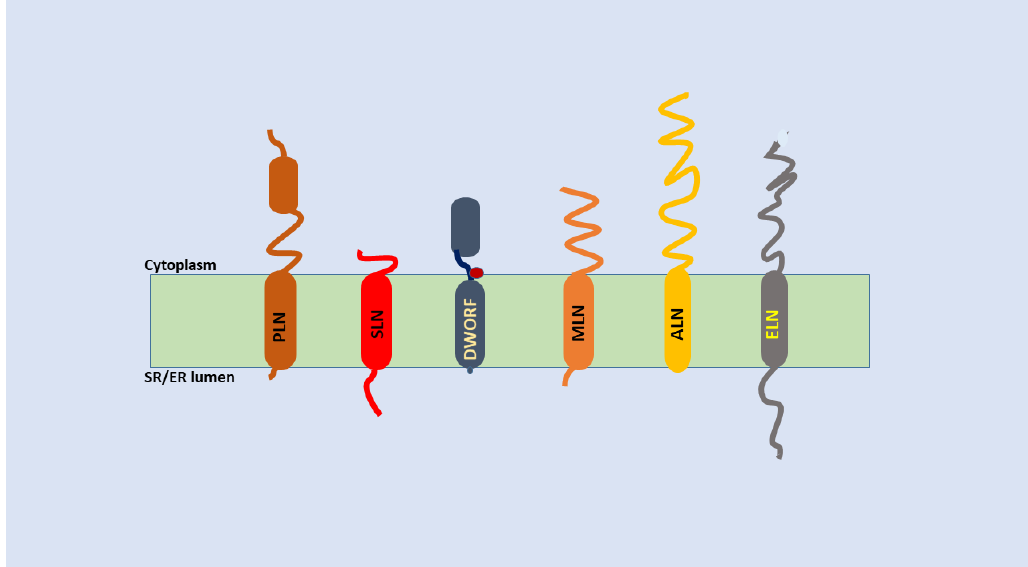
Figure 2. Illustration of regulins in the ER/SR membrane made after the topology models in [66], the cylinders are helices and sinuous lines indicate other regions. PLN – phospho-lamban, SLN – sarco- lipin, DWORF – dwarf open reading frame, MLN – myoregulin, ALN – another-regulin, ELN – en- doregulin. The position of the Pro(15) residue involved in kinking of DWORF is marked by a dark red circle.